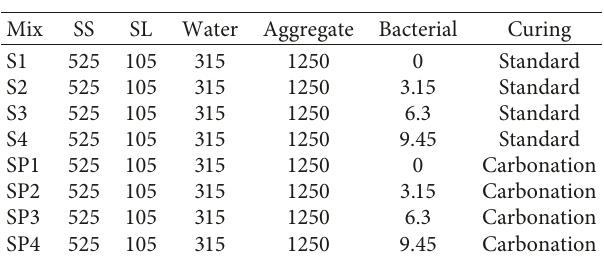
Table 3: Mix proportions